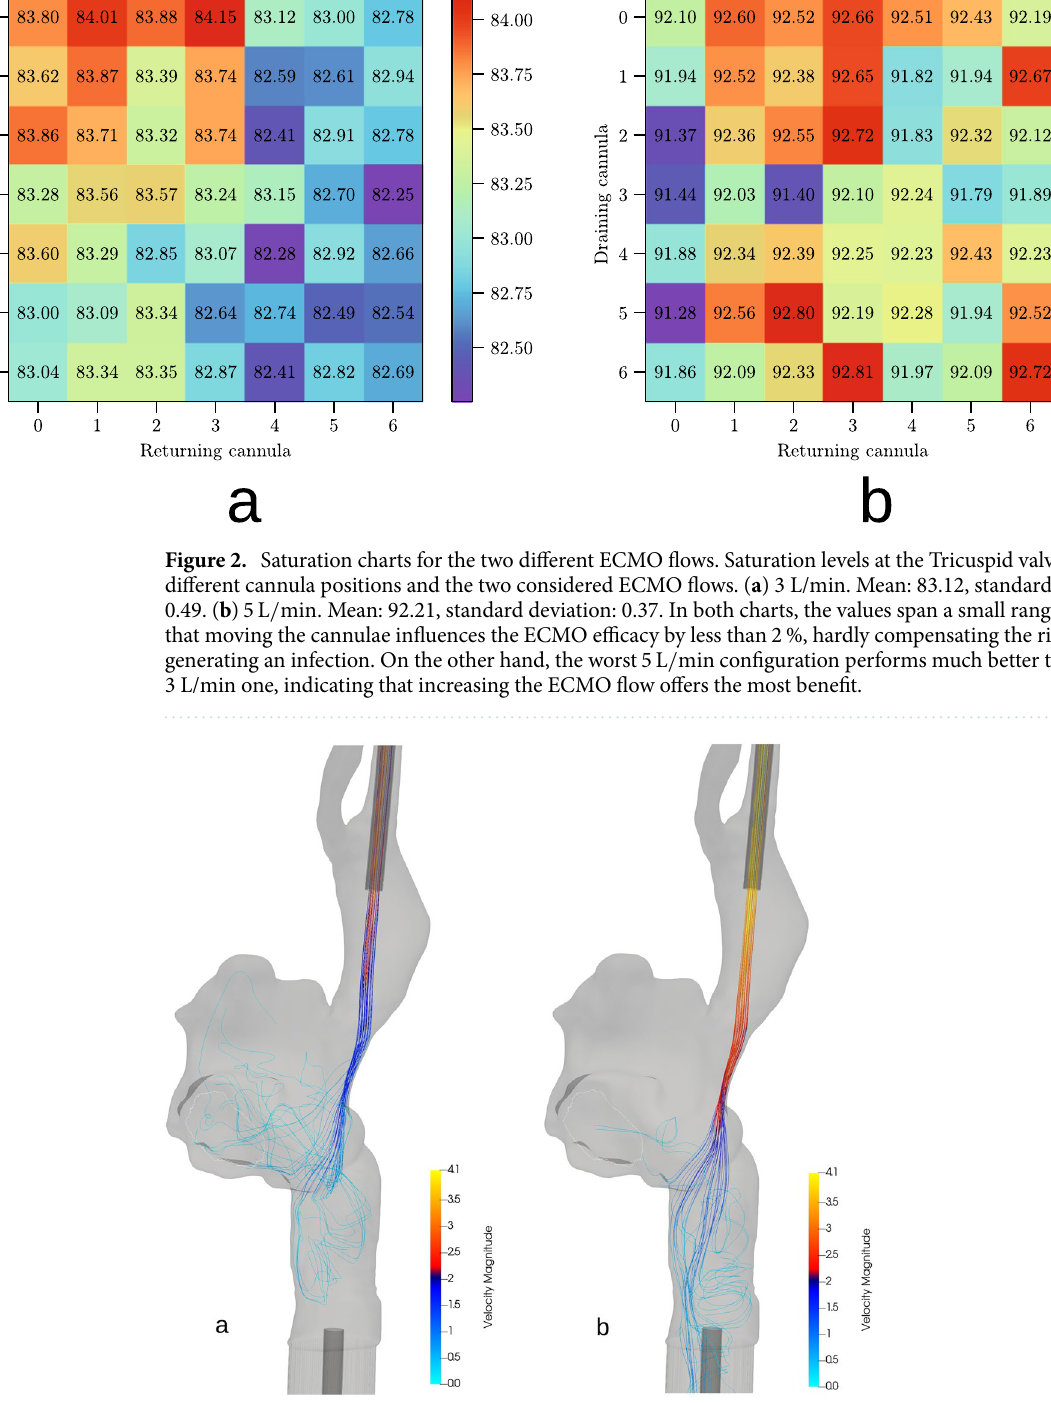
Figure 3. Streamlines for the blood flow for the same configuration with two different ECMO flows. Streamlines showing the path of the oxygenated blood from the returning cannula for the same configuration ( 5, 5 ) with two different ECMO flows, coloured by the blood velocity. Both snapshots are taken while the Tricuspid valve is open. In the 3 L/min case the oxygenated blood, coming in at moderate speed, flows mostly into the Tricuspid valve. In the 5 L / min case a bigger share of the injected blood, coming in much faster, flows through the right atrium and recirculates into the draining cannula. A video of the time evolution of the streamlines is available in Additional file